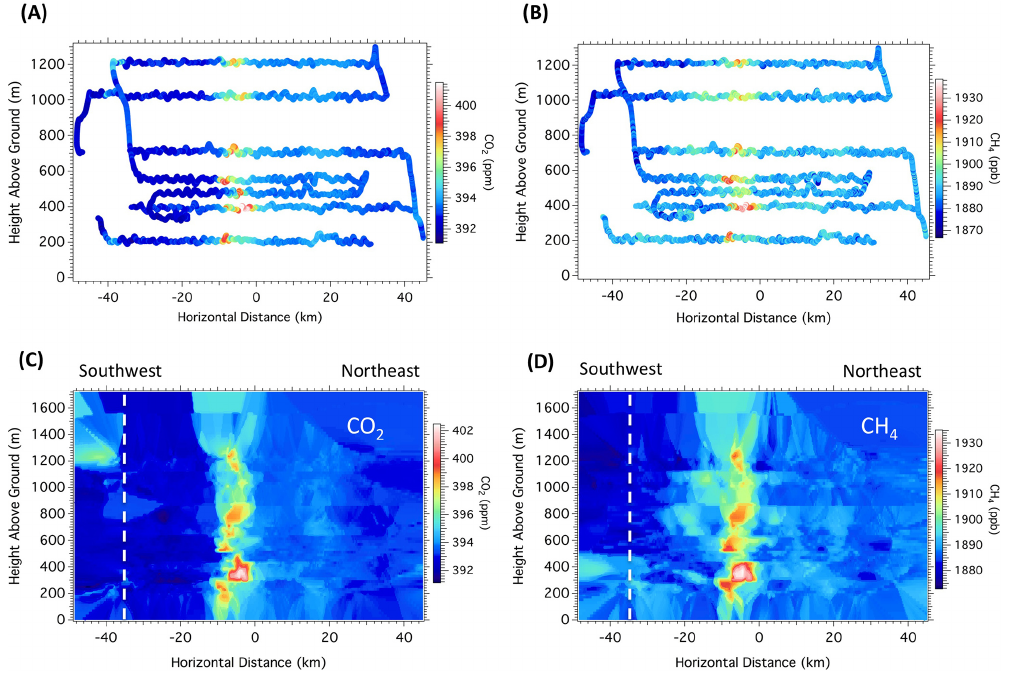
Figure 4. Horizontal and vertical distributions of (a) observed CO 2 , (b) observed CH 4 , (c) kriged CO 2 , and (d) kriged CH 4 on 1 June 2011 corresponding to the transects in Fig. 1. The northeast end corresponds to positive distances while the southwest end corresponds to negative distances relative to the chosen center point. The projected city limits were from − 35km (broken line) to + 45km. CBL depth was